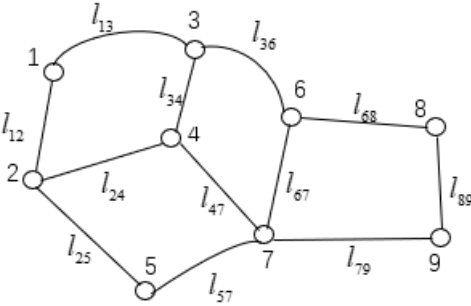
Figure 2. Tra ffi c network topology Figure 2. Traffic network topology diagram.